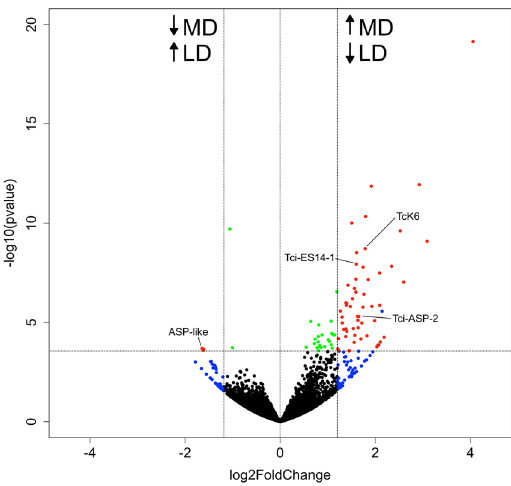
Figure 2. Volcano plot showing log2 (fold change, FC) against − log10 (p-value) of transcripts identified by RNASeq analysis of MD and LD T. circumcincta L4. Transcripts significantly differentially expressed between three replicates of luminal and mucosal dwelling T. circumcincta larvae are highlighted in red (FDR corrected p-value of ≤ (FDR corrected p-v) and a FC ≥± 1.5). Green dots indicate significant transcripts with a FC ≤ 1.5; blue dots indicate transcripts with a FC ≥± 1.5 but with an FDR corrected p-value of ≥ 0.05; whilst black dots indicate non-significant transcripts with a FC ≤ 1.5. Arrows further indicate the direction of up-regulation and down-regulation of transcripts in mucosal dwelling (MD) or lumen dwelling (LD)